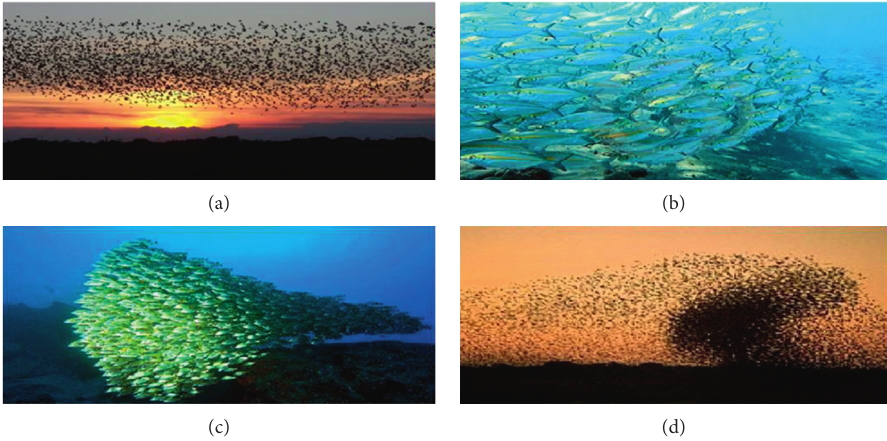
Figure 7: The movement of flock of birds, school of fish, and insect swarm used as a guideline for particle swarm